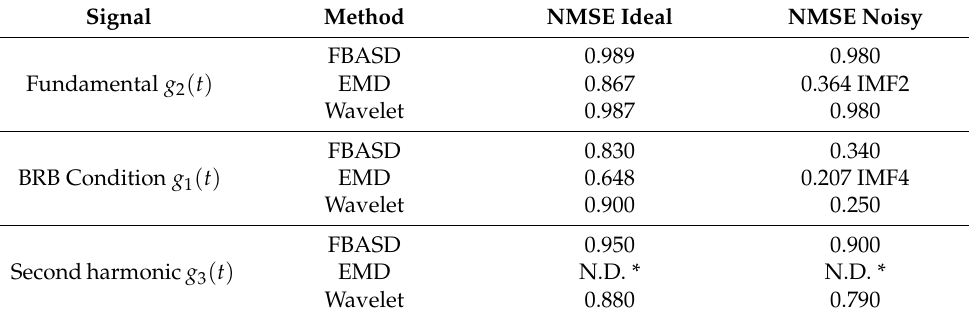
Table 1. Quantitative comparative using NMSE. Signal